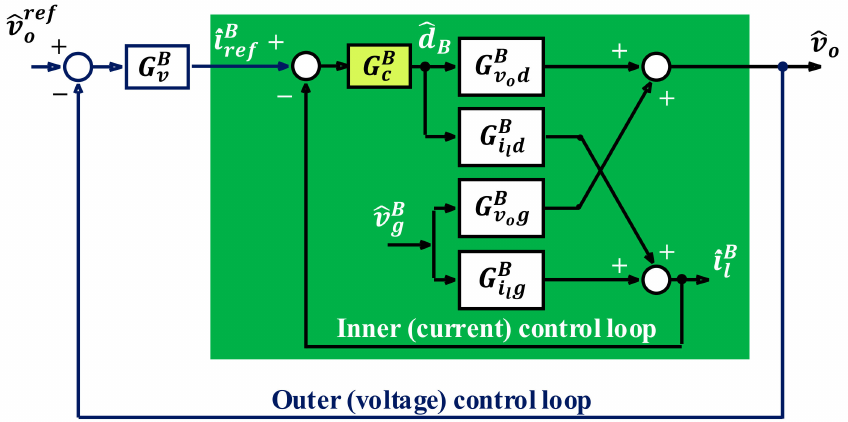
Figure 13. Current programmed bidirectional model with a two loops cascade